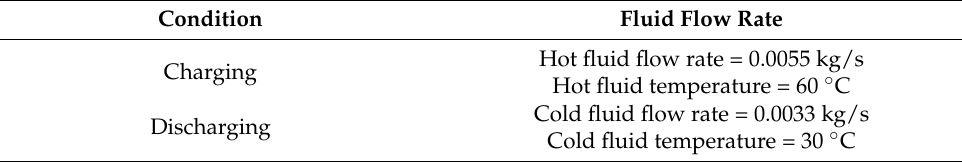
Table 4. Experimental conditions during the charging and discharging cycles.